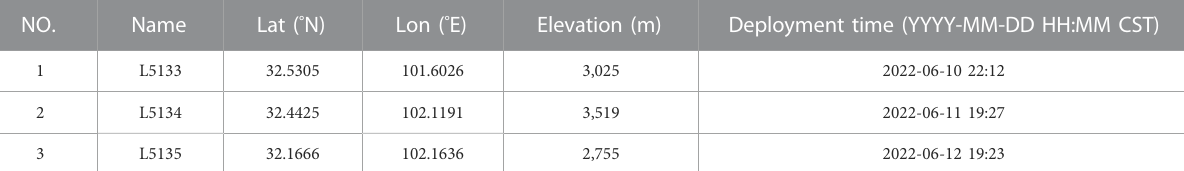
TABLE 1 Locations and deployment times for the three portable stations. NO.